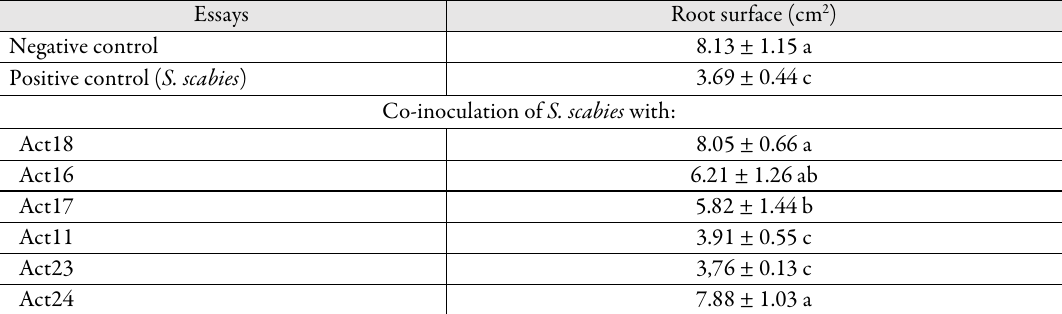
Table 6. Biocontrol of actinomycetes against S. scabies on radish seedlings